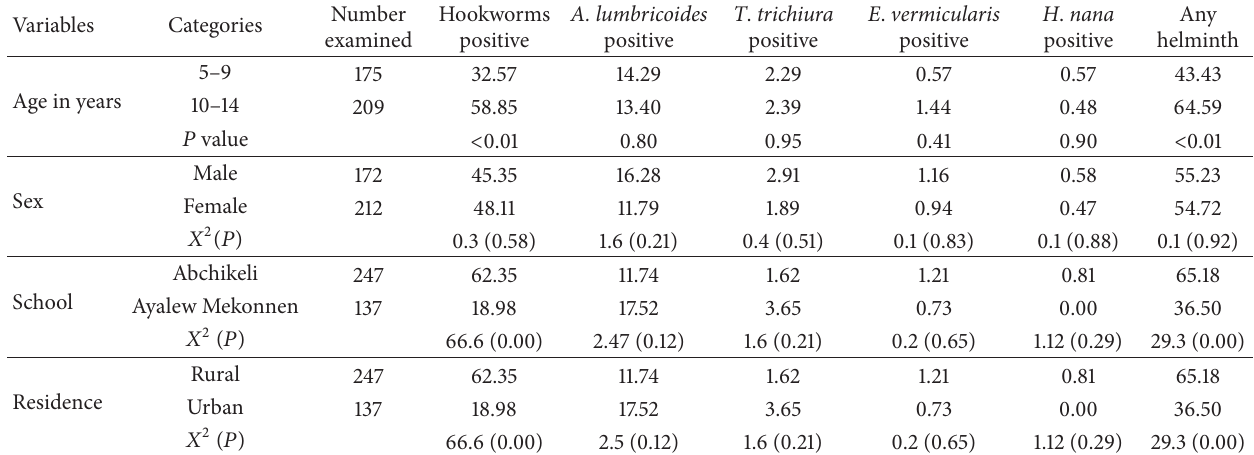
Table 1: Prevalence of soil-transmitted helminth infections among schoolchildren in Abchikeli and Ayalew Mekonnen Elementary Schools, Durbete town, northwestern Ethiopia, February to March